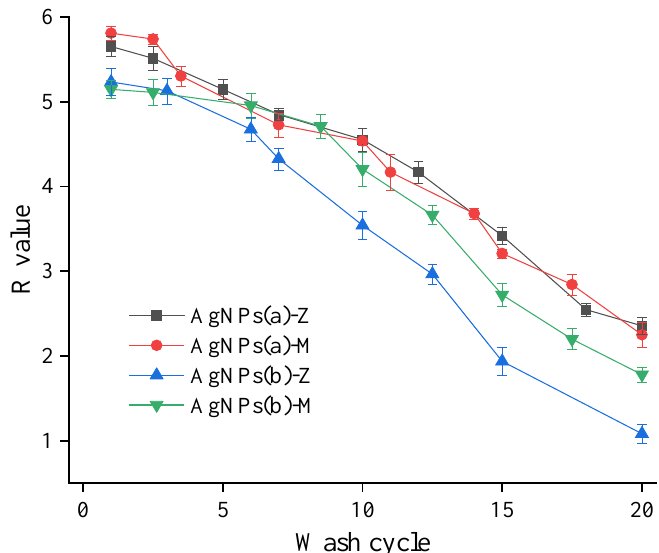
Figure 5. Durability of antimicrobial coatings.